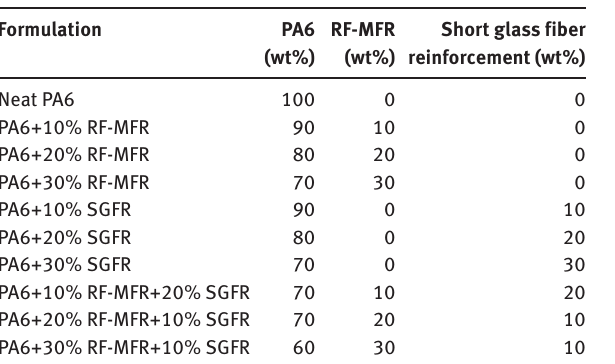
Table 4 Short glass fiber (SGFR)- and Rockforce (RF-MFR) mineral fiber-reinforced PA6 composite formulations.